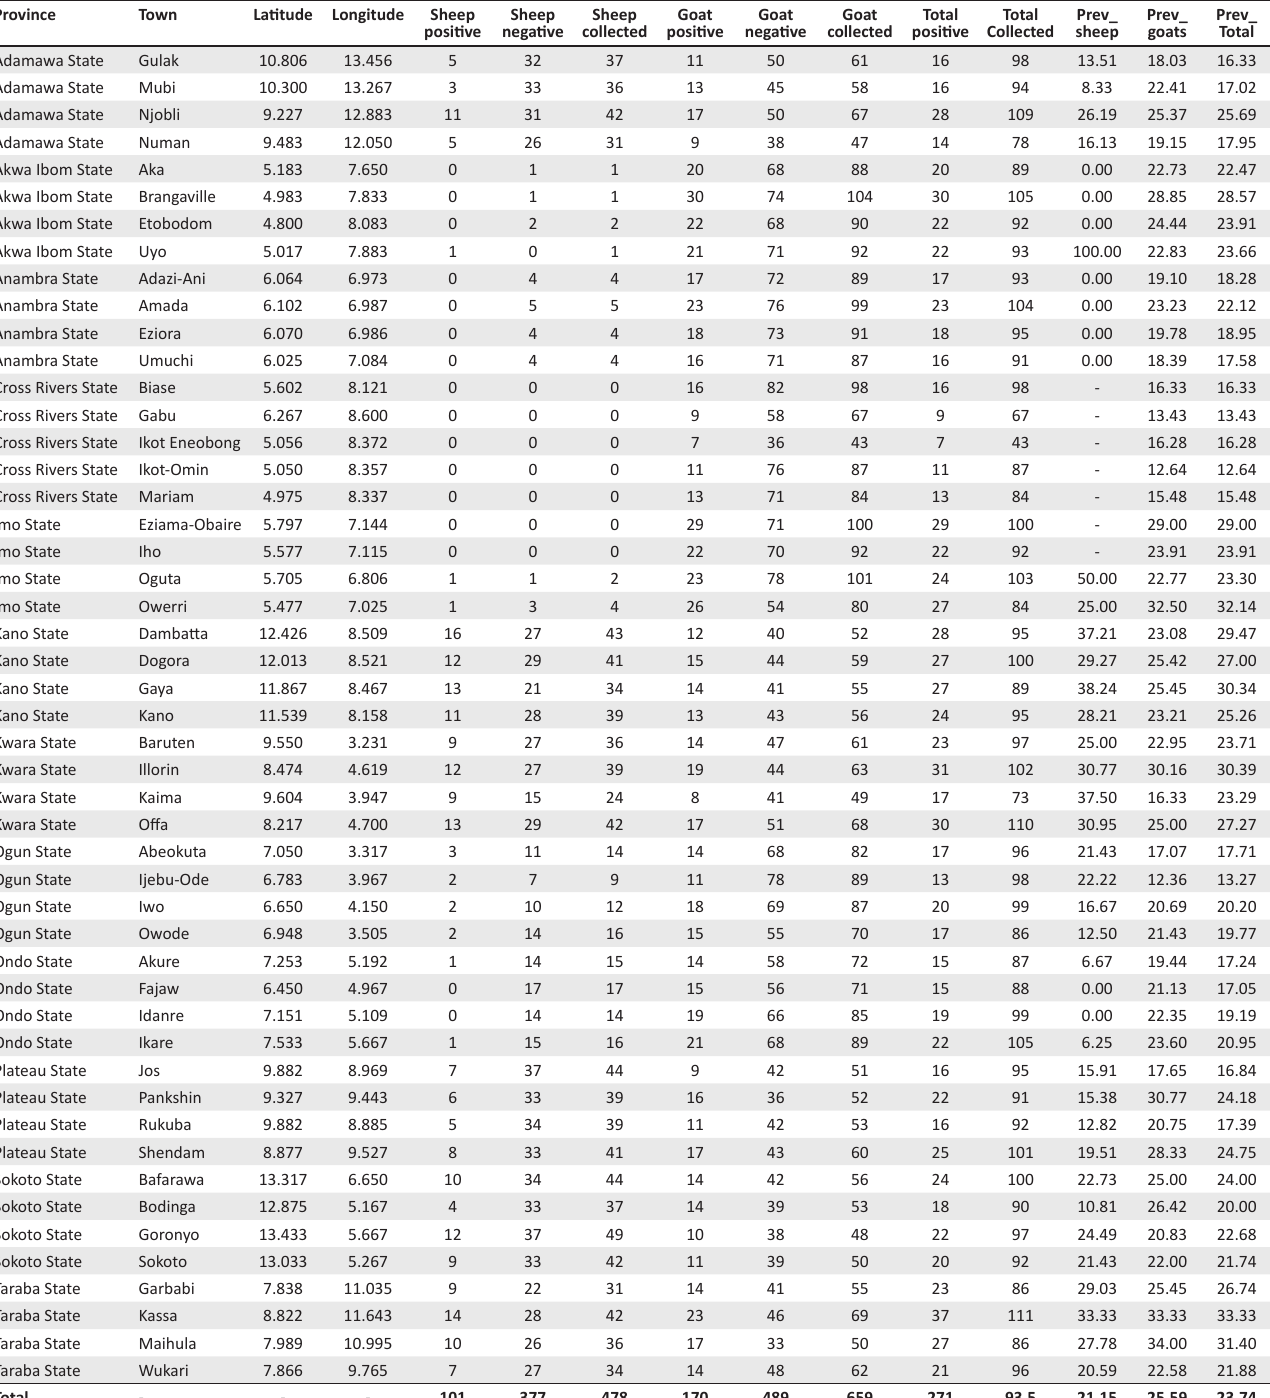
TABLE 1-A1: Small-ruminant peste des petits ruminants virus seroprevalence survey from different localities in Nigeria,